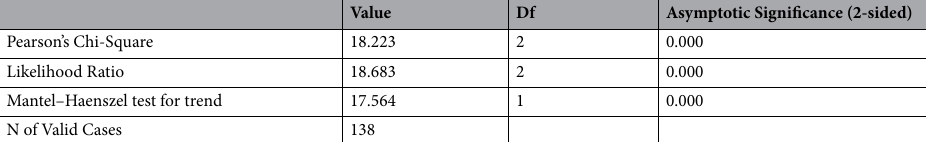
Value Df Asymptotic Significance (2-sided) Pearson’s Chi-Square 18.223 2 0.000 Likelihood Ratio 18.683 2 0.000